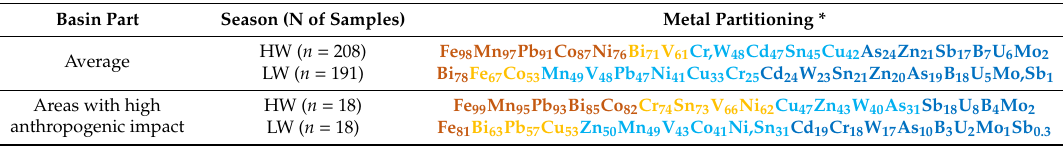
Table 3. Average trends of metal partitioning in the Selenga